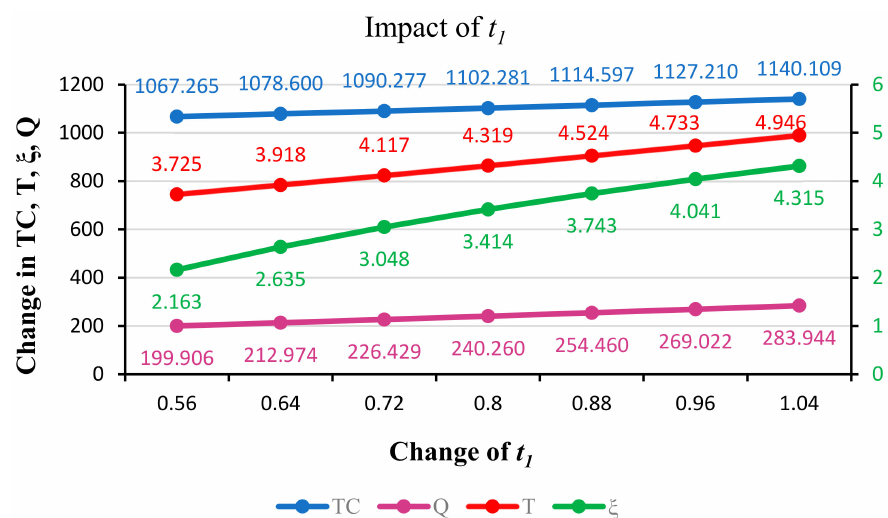
Figure 9. The relationship among t 1 and TC, T, ξ , Q .